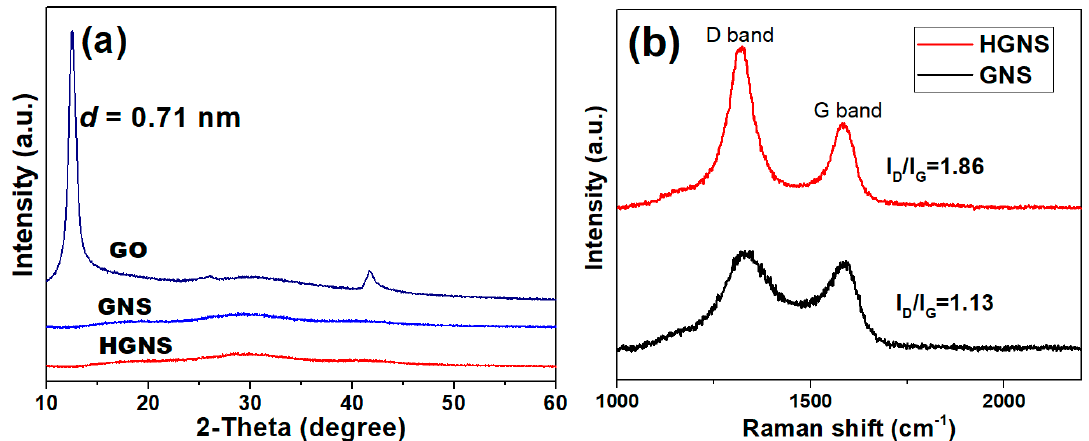
Figure 4. ( a ) X-ray diffractometry (XRD) results for graphene oxide (GO), non-holey graphene (GNS) and HGNS. ( b ) Raman spectra for GNS and HGNS. and HGNS. ( b ) Raman spectra for GNS and HGNS. Table 3. EA anlysis of GO, GNS and HGNS samples. Table 3. EA anlysis of GO,GNS and HGNS samples.